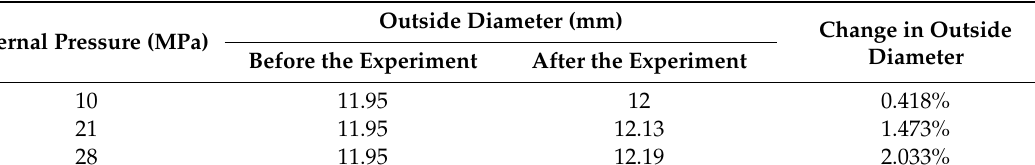
Table 2. Change in the outside diameter of the pipe.